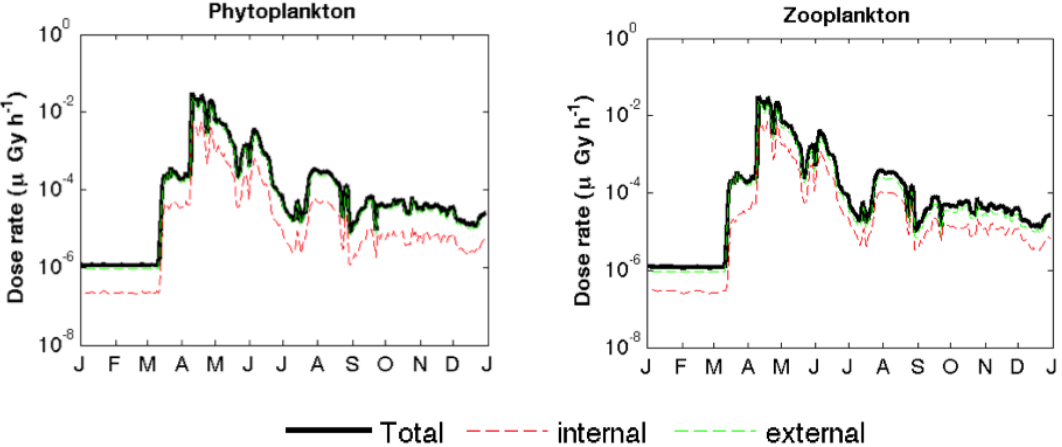
Figure 12. 137 Cs dose rates received by plankton populations located at less than 30km from